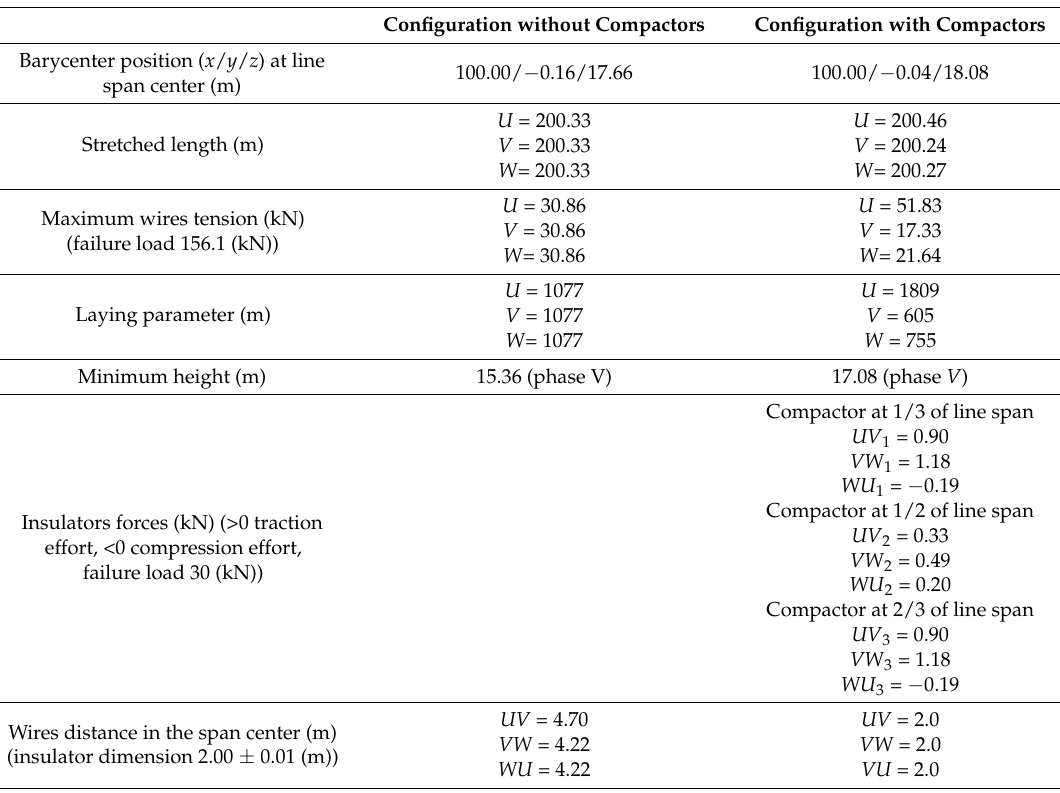
Table 4. Mechanical results without and with three compactors along the line span (MSB